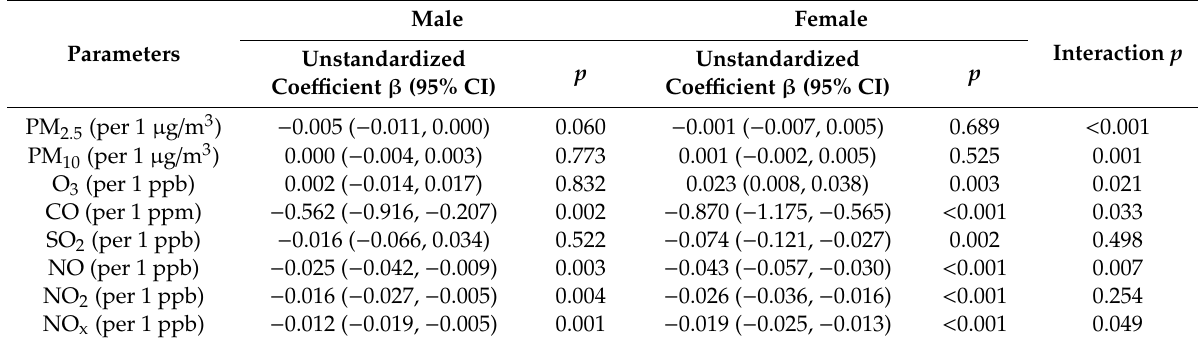
Table 4. Association of air pollutants with BMD T-score using multivariable linear regression analysis in male and female participants.